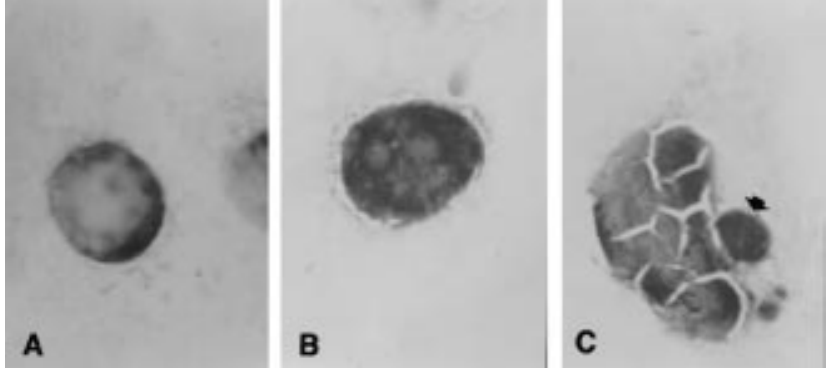
Fig. 5. Appearance of DNA strand breaks (blue colour) in apoptotic macronuclei stained immunocytochemically by nick translation. Macronuclei with crescent-like staining (A), total staining (B) and fragmented (C) macronucleus. Arrow points to an apoptotic micronucleus. DNA was counterstained by Feulgen procedure. Obj. 90 (cid:2) , oc. 7 (cid:2) .